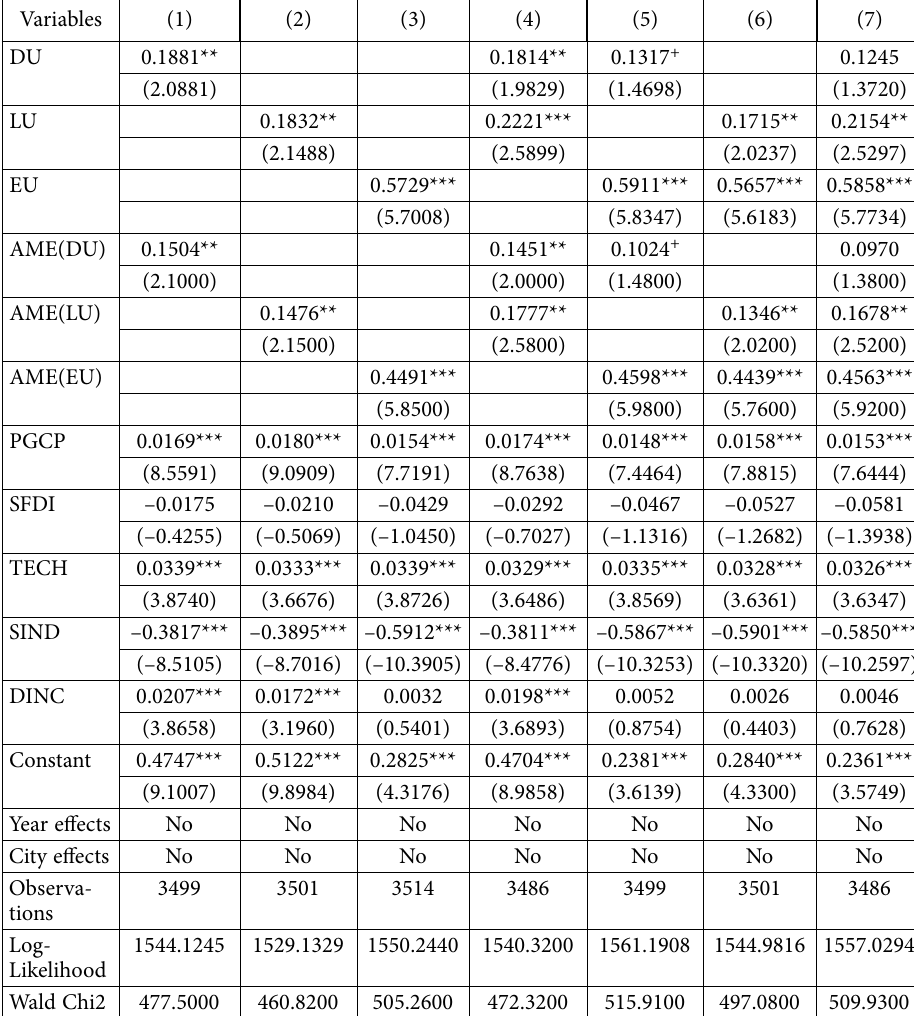
Table 3. Estimation results of Tobit models with random